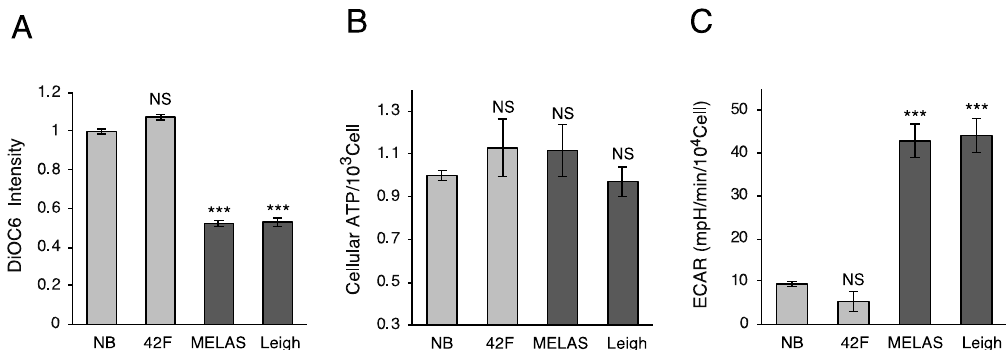
Figure 3. Mitochondrial functions in MD fibroblasts. ( A ) Mitochondrial membrane potential is reduced in MD fibroblasts. Mitochondrial membrane potential was measured by staining the cells with 3,3 ′ -dihexyloxacarbocyanine iodide (DiOC6) fluorescent dye and subsequently analyzed using flow cytometry. ( B ) ATP levels are not different between MD and healthy fibroblasts. Cellular ATP concentrations were assessed using CellTiter-Glo ® (Promega). ( C ) Increased glycolysis in MD fibroblasts. Extracellular acidification rate (ECAR) was measured in MD and healthy fibroblasts by using Seahorse xFp. All data were analyzed using one-way ANOVA followed by Dunnett’s test. Error bars represent ± SD ( n = 4 independent experiments). ***P < 0.001 compared with new born (NB).